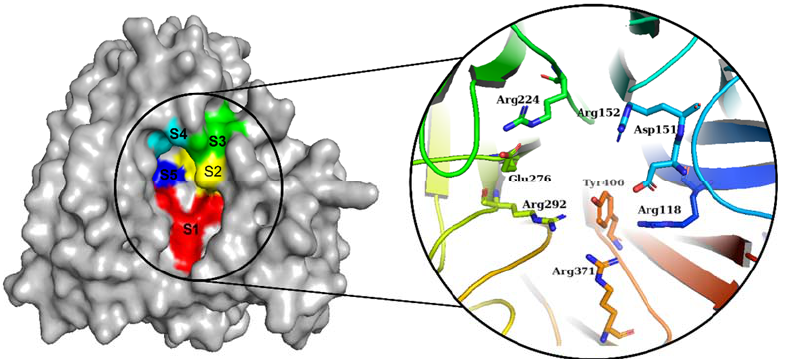
Figure 1. Diagram of the NA binding pocket showing five inhibitory binding subsites (S1 to S5) and conserved enzymatic residues.